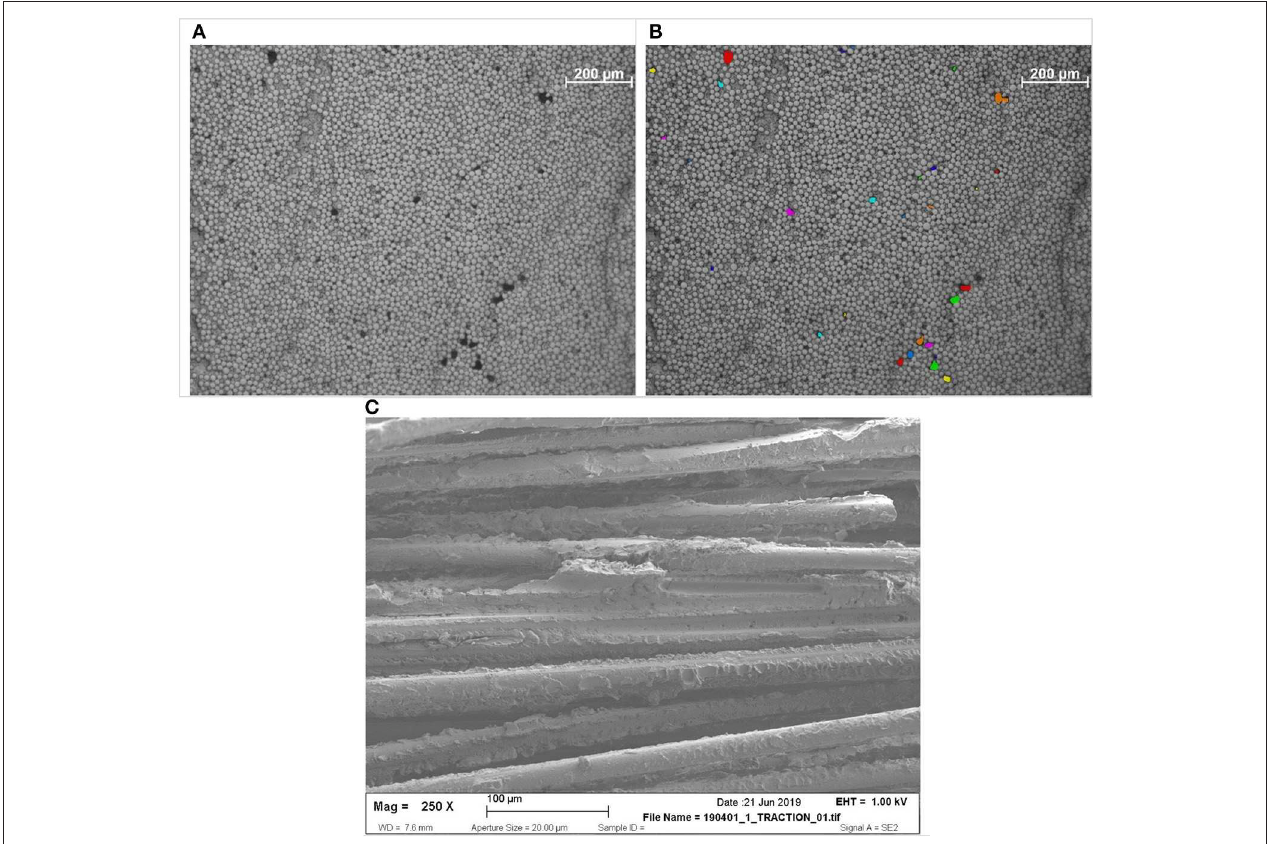
FIGURE 7 | Microscope of cross-section sample with ELIUM C595 E. (A) Original photo. (B) Photo with indicated porosity used for calculations. (C) MEB picture of sample with broken surface after tensile testing.